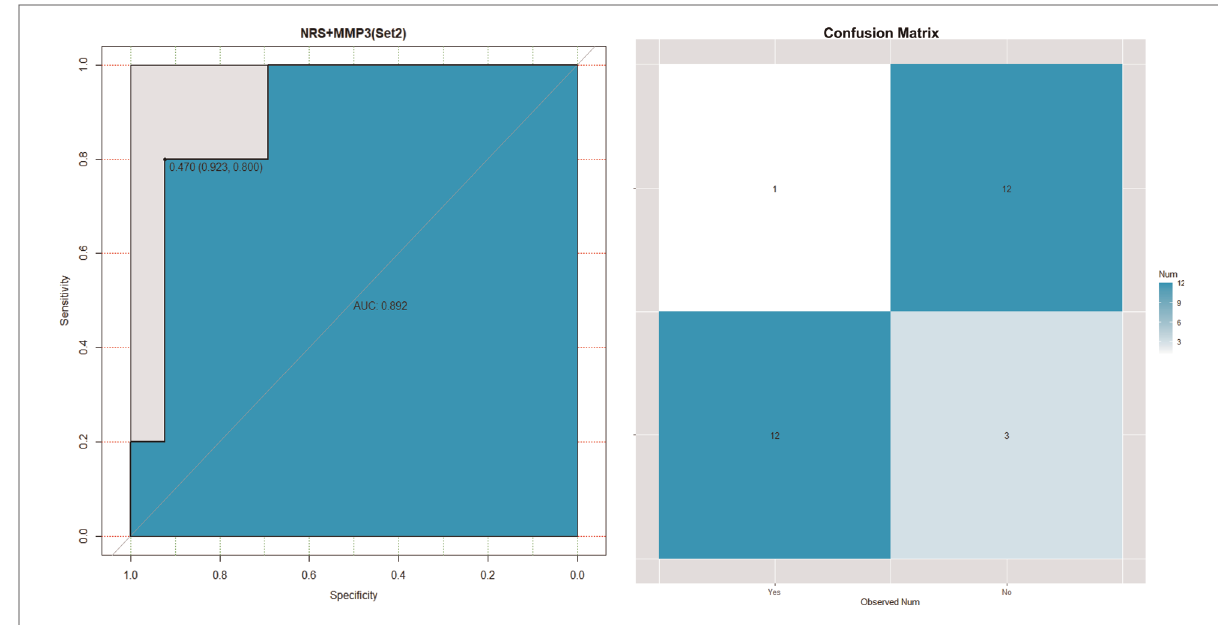
FIGURE 6 Roc curve and predicted result of the fi nal SVM model for CPSP risk in Set